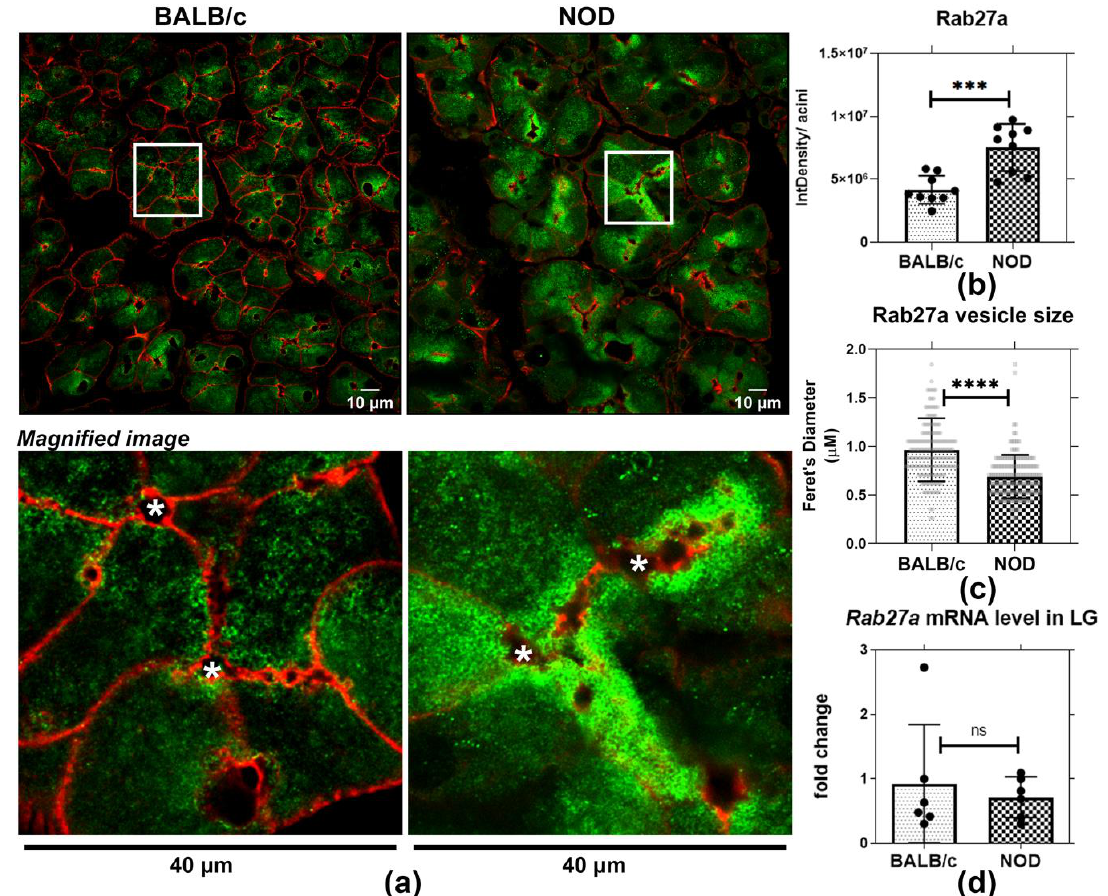
Figure 2. Increased accumulation on subapically-enriched vesicles and reduced vesicle diameter characterizes Rab27a- enriched vesicles in male NOD mouse. Tissue sections from 3–4 mice per strain were quantified, 3 ROI were obtained from each section. ( a ) Indirect immunofluorescence microscopy of Rab27a labeling (green) revealed increased accumulation of Rab27a-enriched vesicles near the apical lumen. ( b ) The increased intracellular accumulation of Rab27a was quantified per acinus, and was increased in male NOD mouse acini relative to BALB/c mouse acini. ***, p = 0.0003 (N = 4). Red, actin filaments. Integrated density of three acini were quantified and averaged in each ROI, presented as points on the graph. ( c ) Feret’s diameter of Rab27a-enriched vesicles was significantly decreased in LG sections from NOD mice relative to vesicles in LG sections from BALB/c mice. ****, p ≤ 0.0001 (N = 4). 30–40 vesicles from three acini were quantified from ROI, presented as points. ( d ) No significant changes in Rab27a gene expression were detected in NOD versus BALB/c mouse LG. ns, p = 0.6057 (N = 6). N = mice per group. *, Lumen.